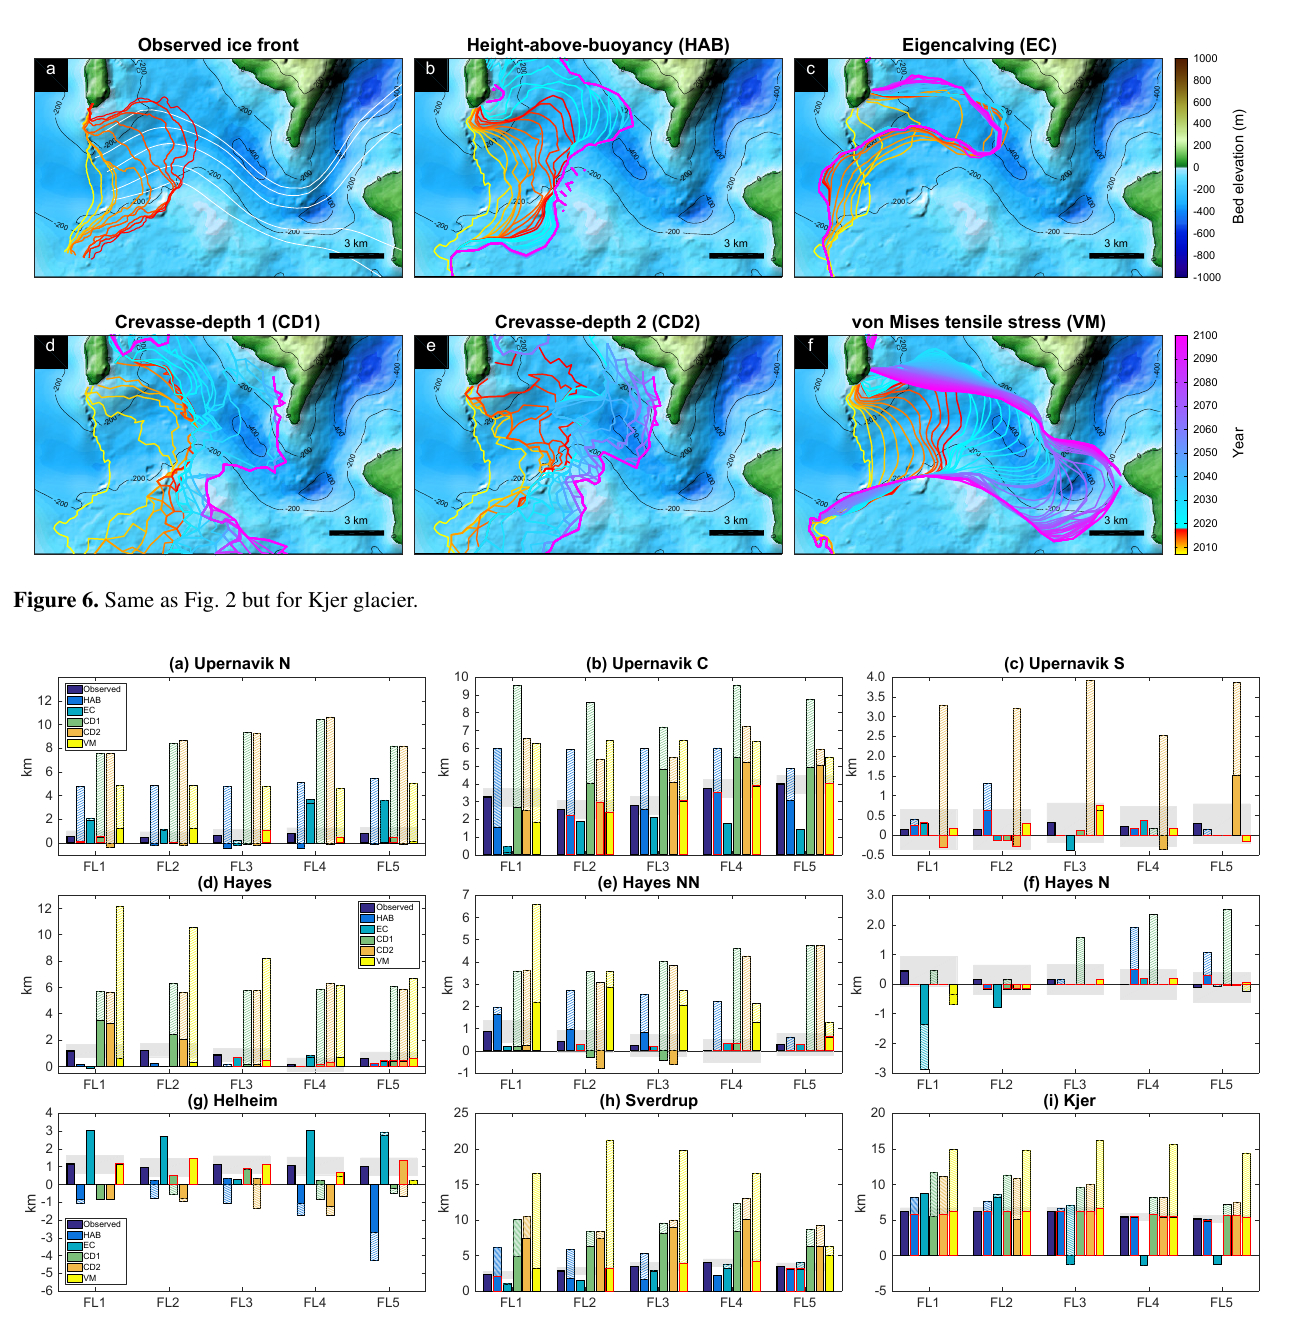
Figure 7. Modeled retreat distances (with respect to the calving front initial position in 2007) for different calving laws compared to observed retreat distance for nine study glaciers. The retreat distances between 2007 and 2017 from each calving law are shown as bar solid colors. The hatched bars are the retreated distances in 2100 for each calving law. Shaded areas represent the range of 500m from the 2017 observed retreat, and the modeled retreats that fall into this range are shown with the red